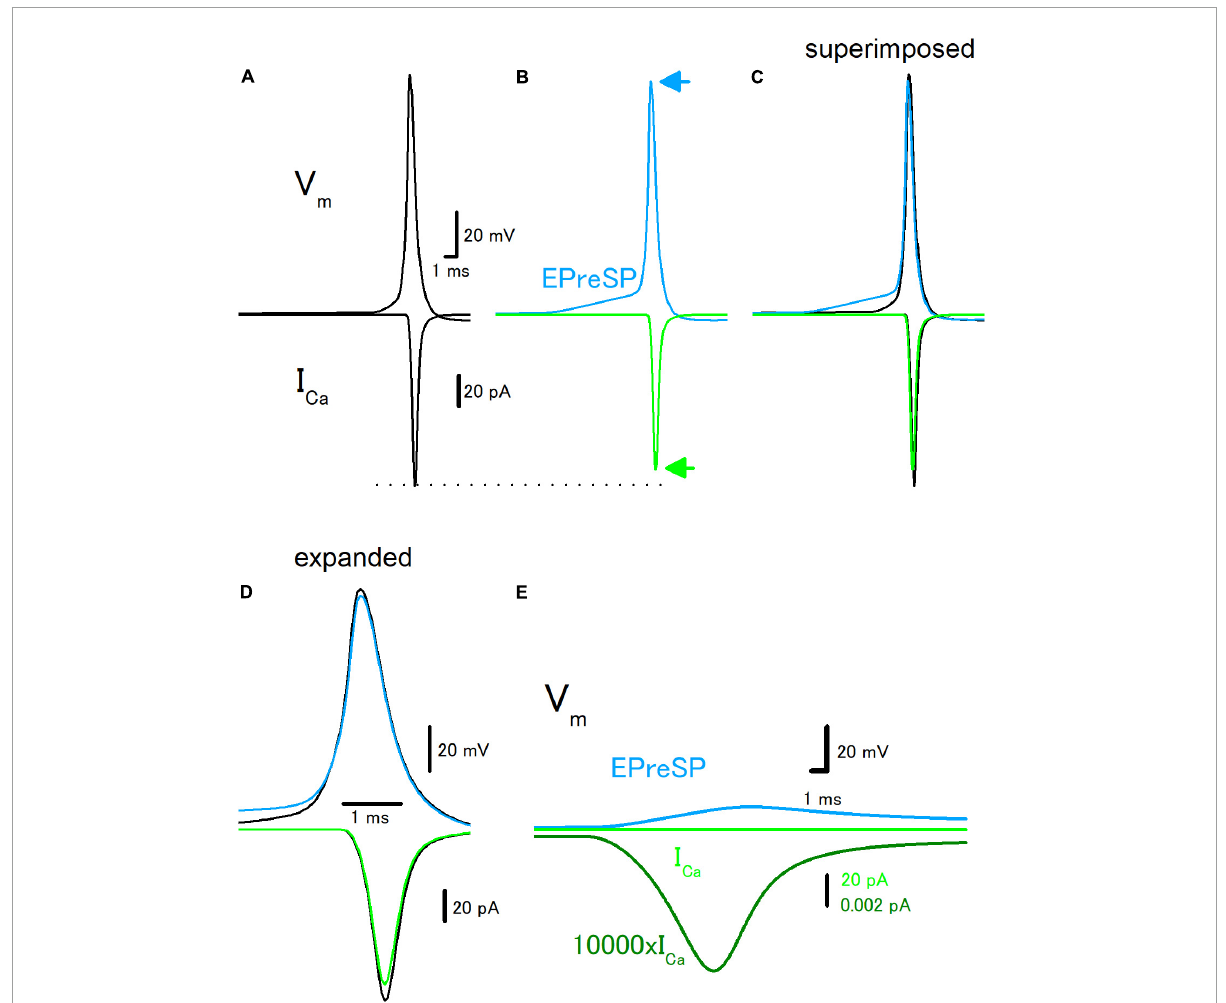
FIGURE3 Effects of EPreSP on the propagating action potential and presynaptic calcium current. (A) Simulated propagating action potential (V m : upper) and presynaptic calcium current (I Ca : lower) of the first mossy fiber bouton of the main trunk in the control condition. (B) Propagating action potential (blue) and presynaptic calcium current (green) were calculated with the preceding EPreSPs elicited by stimulation of dendritic input. The synaptic conductance was set to evoke somatic EPSPs of approximately 20 mV. Superimposed (C) and time expanded (D) traces of propagating action potential and presynaptic calcium current. (E) Subthreshold EPreSP (blue)-induced presynaptic calcium current (green) and that of magnified 10,000 times (dark green). Note that the subthreshold EPreSP itself elicited substantial presynaptic calcium